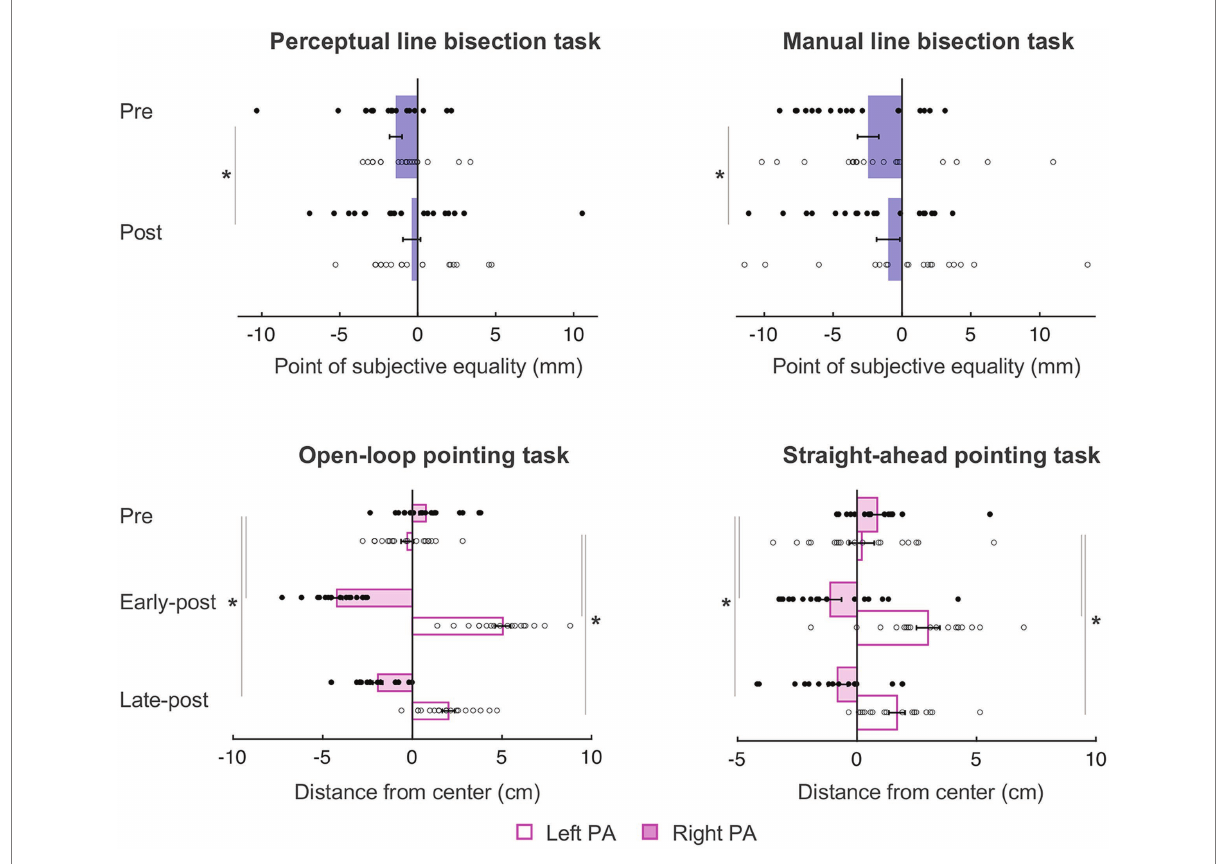
FIGURE 3 Behavioral results. Negative and positive values represent left and right of the true center (0 cm), respectively. PSE, point of subjective equality; PA, prism adaptation. Error bars represent standard error of the mean. * p < 0.05. Filled circles represent right PA group individual data and open circles represent left PA group individual data. Adapted from figure 2 in Schintu et al.